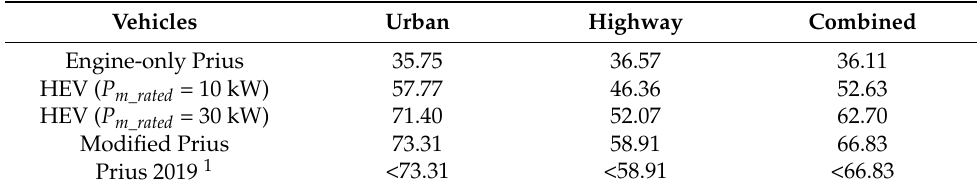
Table 8. Maximum MPGs of Prius-based vehicles.